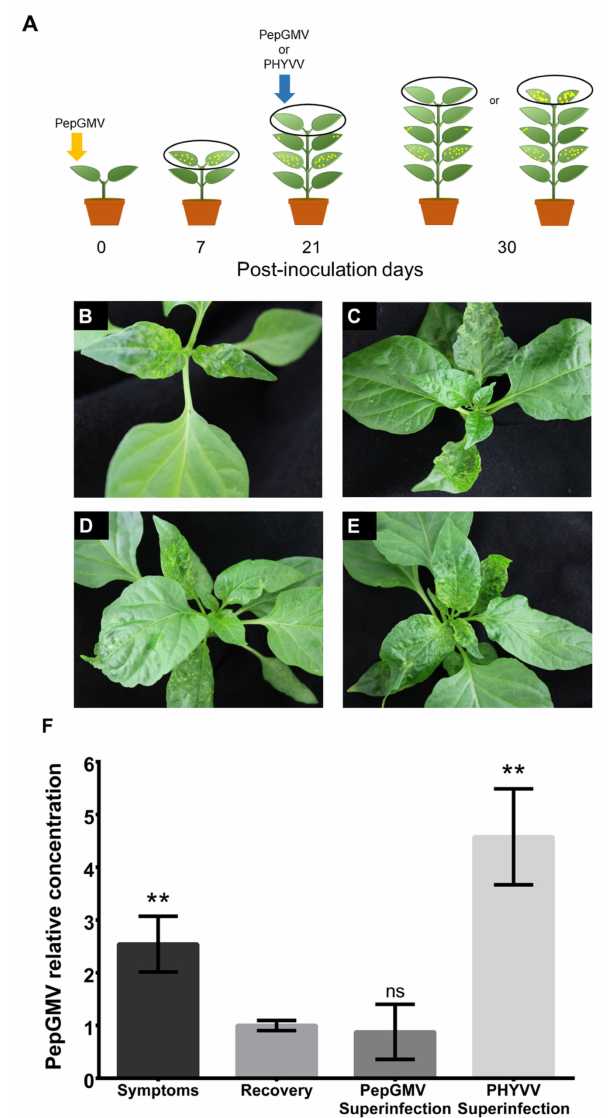
Figure1. Symptomseverityand Peppergoldenmosaicvirus (PepGMV)DNAaccumulation. ( A )Schematic representation of inoculation protocol. Pepper plants initially inoculated with PepGMV developed symptoms at 7 days after inoculation (dpi). Plants showing recovery (21 dpi) were superinfected with either PepGMV or Pepper huasteco yellow vein virus (PHYVV). Newly developed tissue was collected and analyzed at 30 dpi. Black ovals indicate leaves collected for analysis. ( B – E ) Symptom severity: ( B ) PepGMV symptoms, 7 dpi. ( C ) Host recovery, 21 dpi. ( D ) PepGMV superinfected plants, 30dpi. ( E ) PHYVV superinfected plants, 30dpi. ( F ) PepGMV DNA accumulation. Total DNA was isolated from leaf tissue indicated in black ovals in (A). PepGMV DNA levels were quantified by qPCR using the internal gene CaEF1a for standardization. Bars represent the relative concentration of PepGMV DNA using the value obtained in the recovered tissue as reference. Each bar represents the mean value of three independent biological replicates. Each replica is a pool of five plants. Error bars plotted refer to mean standard deviation. Asterisks indicate samples that are statistically di ff erent when compared with the recovered tissue reference (**, p < 0.01, Symptoms-Recovery or PHYVV-Recovery; ns, no significant, PepGMV-Recovery), as determined by Student’s t